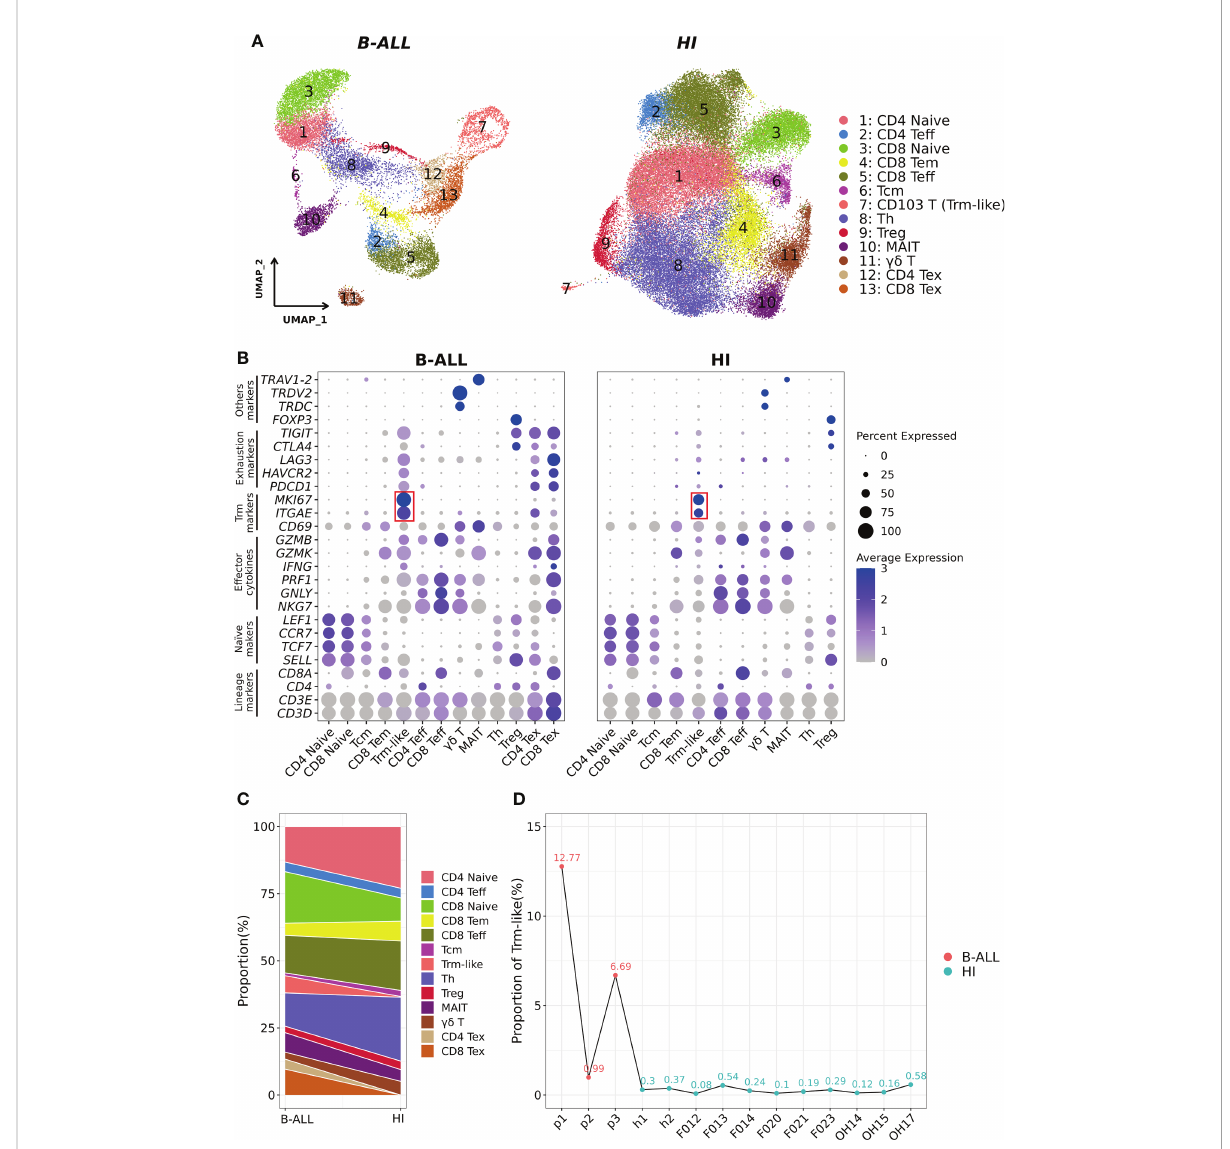
FIGURE 1 Identi fi cation of CD103+ T (Trm-like) cells in the peripheral blood of B-ALL patients and healthy individuals through scRNA-seq. (A) . UMAP (uniform manifold approximation and projection) visualization of T-cell single cell clusters from B-ALL patients (left) and healthy individuals (HI; right). Different clusters are depicted with distinct colors. (B) . Dot plot of marker genes for each cell cluster. Color scale indicates the mean of normalized expression of marker genes in each cell type, and dot size is proportional to the percentage of cells within each cell cluster expressing the marker genes. The red box highlights the marker genes for Trm-like cells. (C) . Variation of the proportion of each de fi ned cell type between sample groups (B-ALL vs . HI). (D) . Proportion of Trm-like cells in each assayed sample. Red and green dots represent B-ALL patients and healthy individuals, respectively. Trm-like, tissue-resident memory-like T cell; B-ALL, B cell-acute lymphoblastic leukemia; Teff, effector T cell; Tem, effector memory T cell; Tcm, central memory T cell; Th, T-helper cell; Treg, regulatory T cell; MAIT, mucosal-associated invariant T cell; Tex, exhausted T